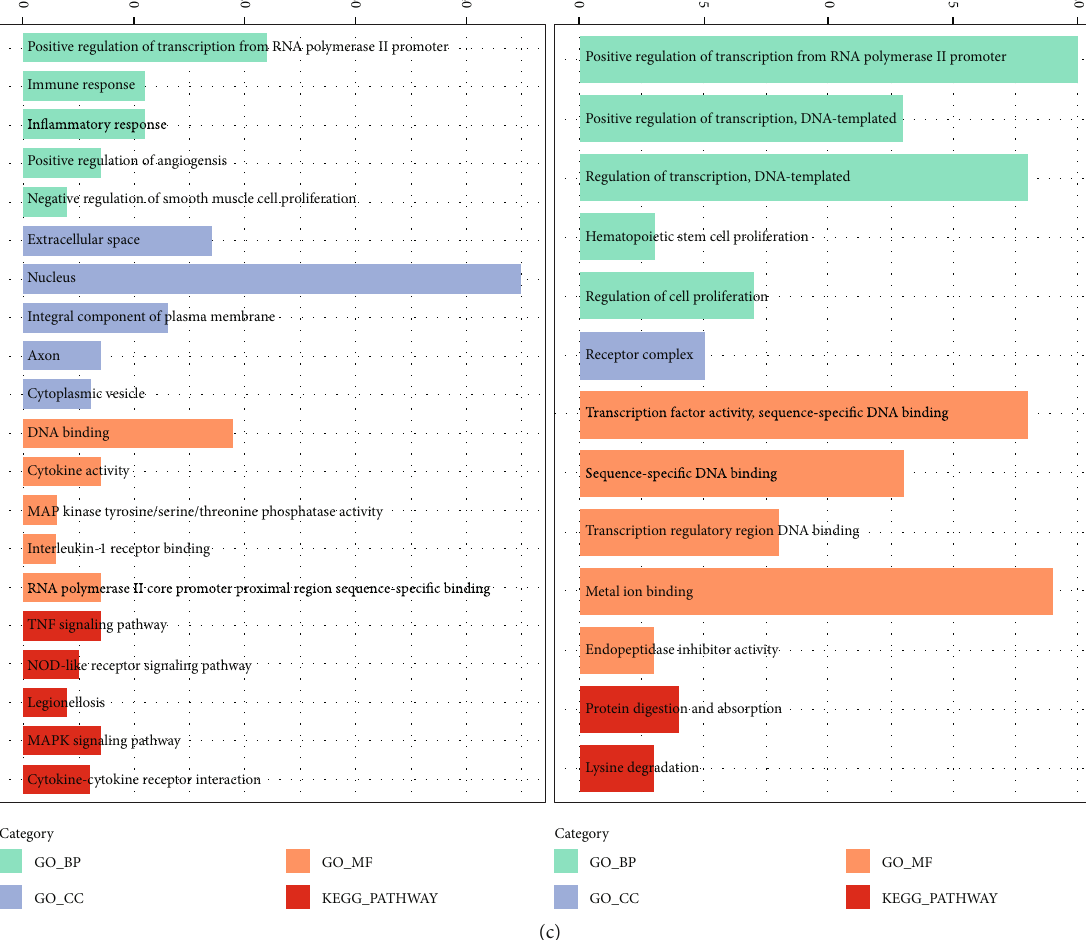
Figure 6: Transcriptome bioinformatic analysis of ADSCs without and with LIPUS stimulation. (a) Heatmap plot of signi fi cantly and di ff erentially expressed genes (DEGs) of ADSCs without and with LIPUS stimulation. (b) The top 12 hub genes of ADSCs without and with LIPUS stimulation were analyzed by CytoHubba. (c) GO and KEGG analyses of upregulated DEGs and downregulated